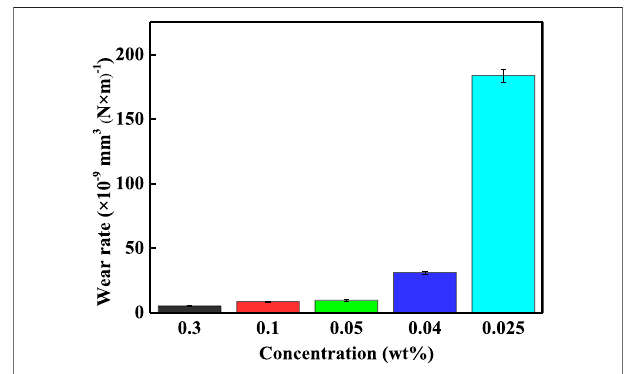
FIGURE 7 | Wear rate under different nanoparticle